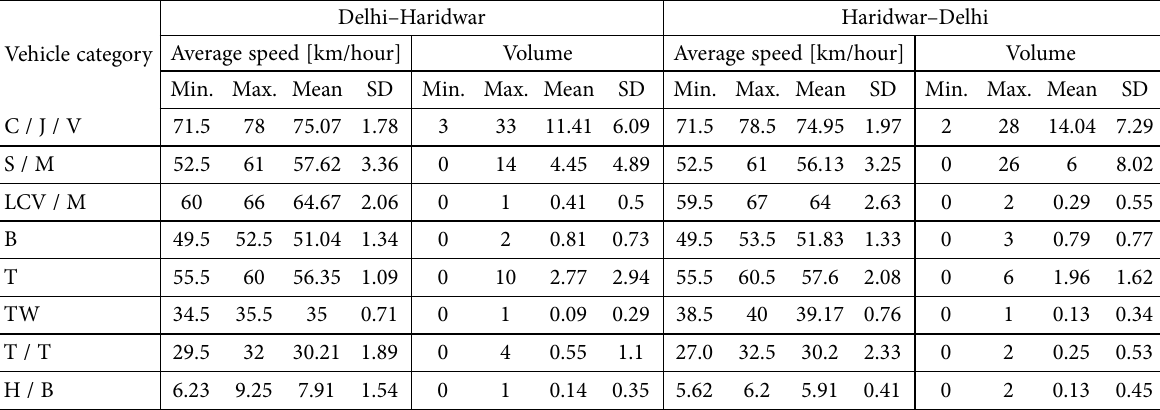
Table 3. Summary of speed and traffic volume measurement for five minutes interval